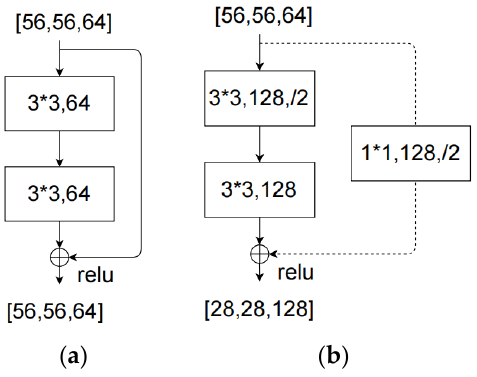
Figure 13. Residual structure ( a ) and ( b